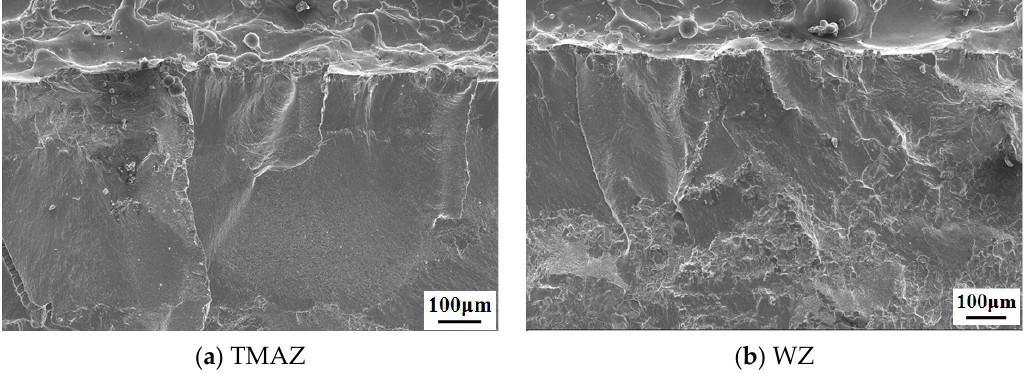
Figure 14. The crack source on the fracture surface of the test piece.